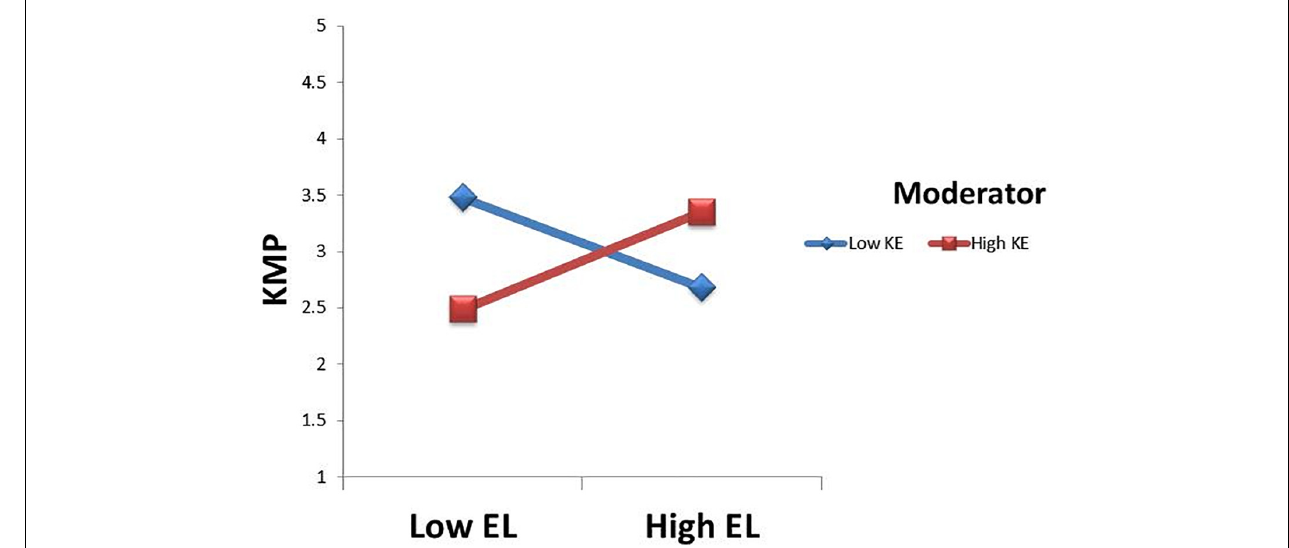
FIGURE 2 | Moderating effect of KE.